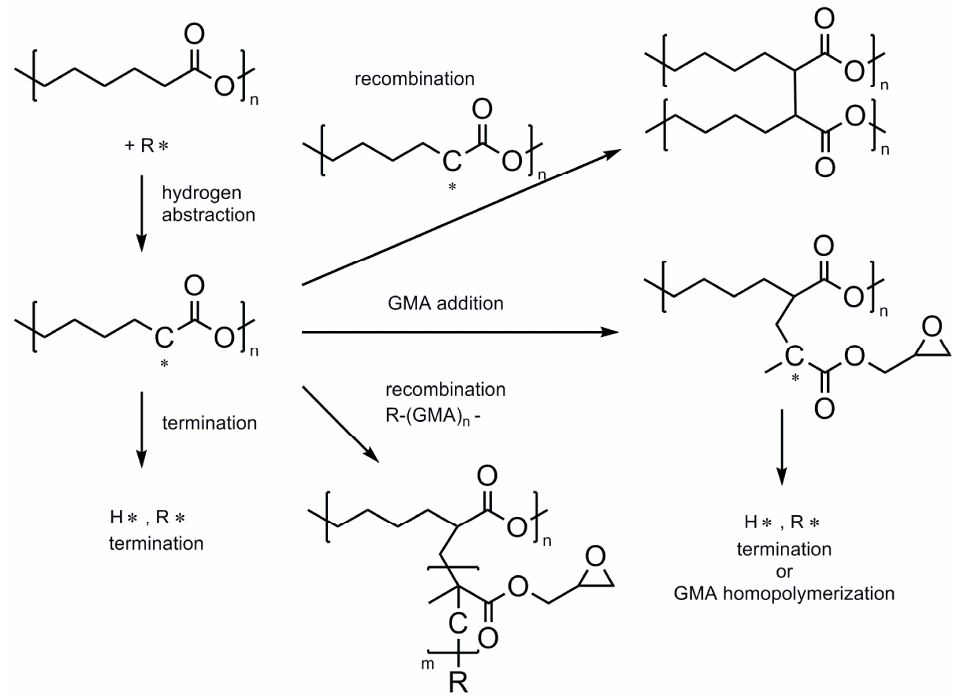
Figure 3. Simplified reaction pathway for grafting of GMA to PCL [9,11].